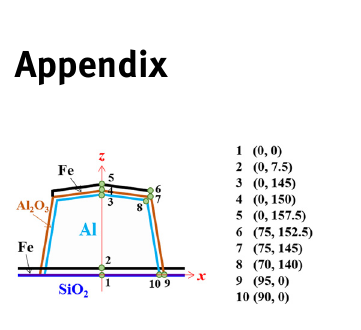
Figure S1: The sketch of Al nanostructure in the x-z plane ( y = 0 nm) for fi nite-difference time-domain (FDTD) calculations, while the co- ordinates ( x , z ) of points from 1 to 10 are provided in the right side in unit of nm.